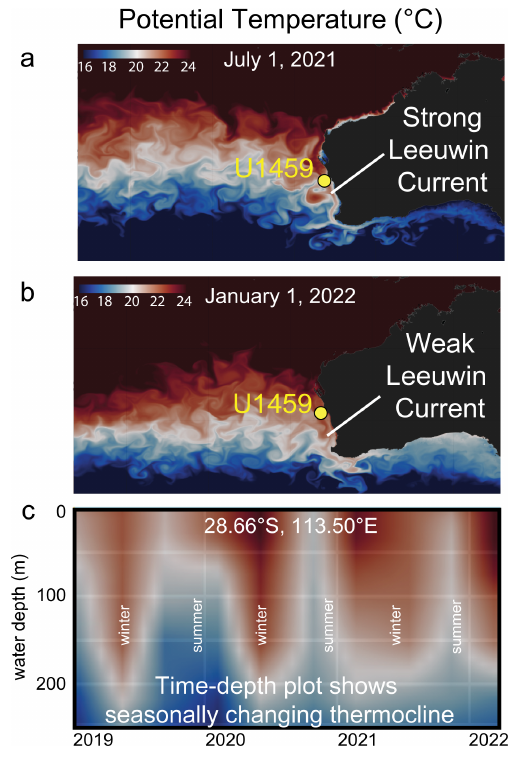
Figure 1. Present-day oceanography of the eastern Indian Ocean. The southward flowing Leeuwin Current is strongest in late autumn and winter. During that season, the Leeuwin Current generates large eddies, causing significant deepening of the mixed layer (down to ∼ 200m) and facilitating enhanced pri- mary productivity (also see Fig. B1). During austral summer, the Leeuwin Current is weaker, with a corresponding thinner mixed layer and reduced productivity. (a) Sea surface temperature on 1 July 2021 (austral winter). (b) Sea surface temperature on 1 January 2022 (austral summer). (c) Time–depth potential temperature plot for the Site U1459 locality. Sea surface tem- peratures vary seasonally between 20 and 24 ◦ C. Figures were generated using EU Copernicus Marine Service Information with data from GLOBAL_ANALYSIS_FORECAST_PHY_001_024 (Zammit-Mangion and Wikle,